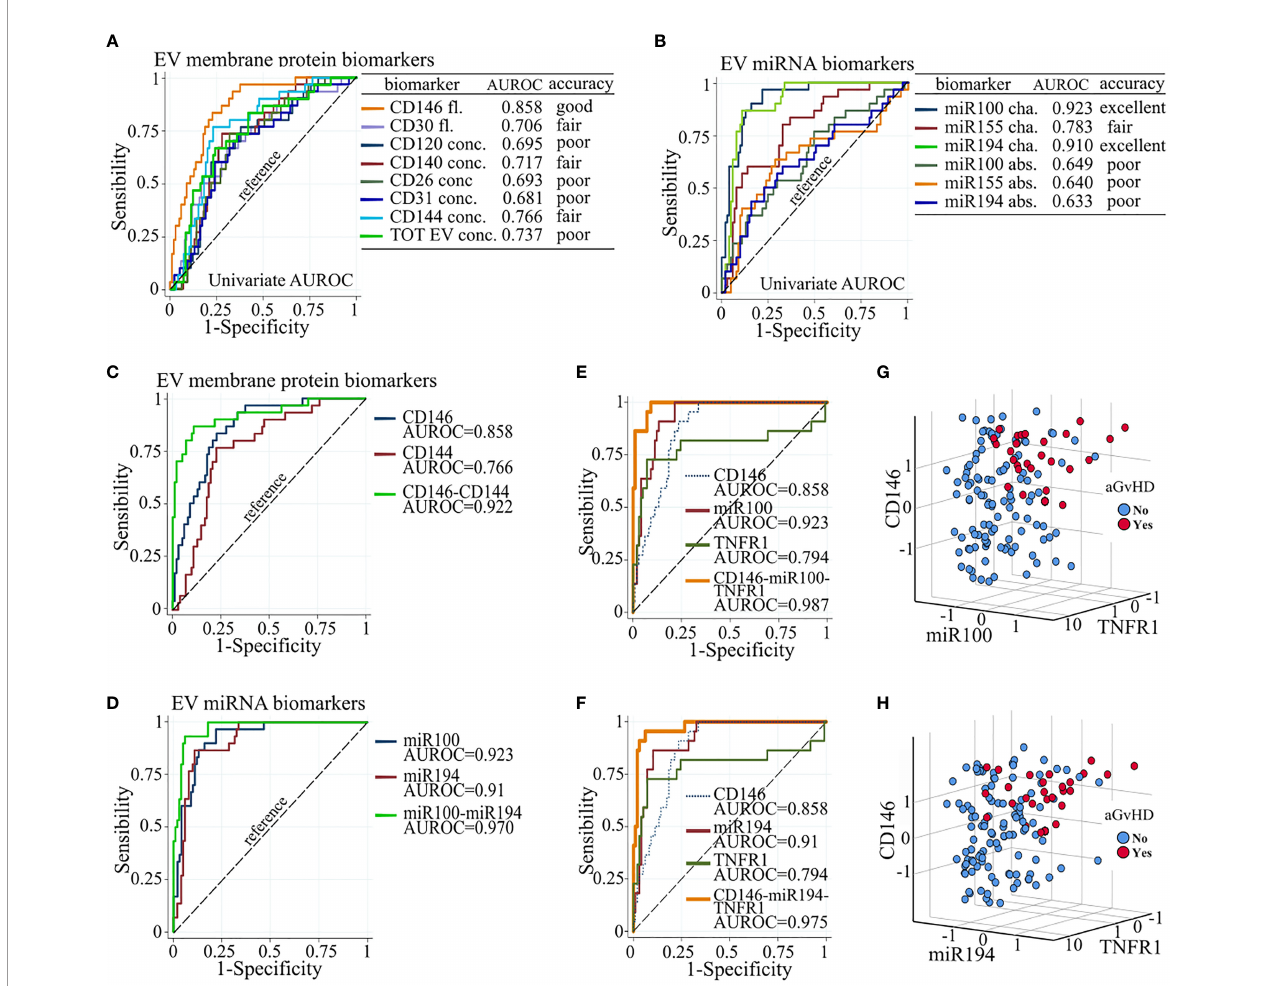
FIGURE 5 | Biomarker combination improves aGvHD prediction. Individual AUROC curve analysis of aGVHD diagnostic performance of (A) EV membrane protein and (B) EV miRNA biomarkers. Individual and multivariate AUROC curve analysis of aGvHD diagnostic performance of (C) CD146 and CD144; (D) miR100 and miR194; (E) CD146, miR100, and sTNFR1; and (F) CD146, miR194, and sTNFR1. AUROC, area under the receiver operating characteristics; dot line, reference line; Fl., fl uorescence; conc., concentration; cha., proportional change from basal; abs., absolute value. Three-D scatter plot of standardized proportional change from baseline of (G) CD146 fl uorescence, miR100 expression, and sTNFR1 plasma concentration, and of (H) CD146 fl uorescence, miR194 expression, and sTNFR1 plasma concentration, in patients with (red) and without (blue)